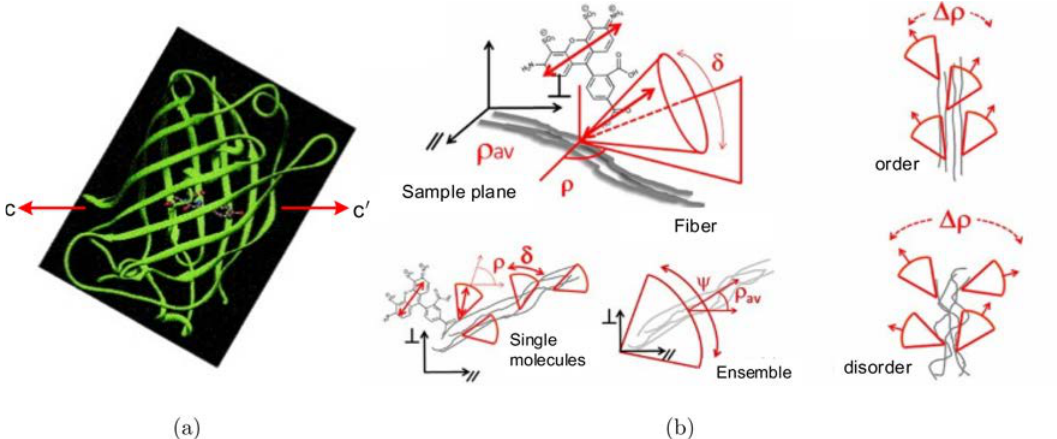
Fig. 1. Schematic illustration of °uorescent dipoles. (a) Schematic structure of Green Fluorescence Protein (GFP) molecule based on X-ray crystallographic analysis. The axis c – c 0 denotes the long crystal axis, which is also parallel to the orientation of the absorption and emission transition moments. (b) Fluorescent dipoles labeled on bio-structures (here, Alexa Fluor 488 labeled on actin, upper-left). Each molecule has its own average orientation ( (cid:2) ) and wobbling angle ( (cid:3) ). The ensemble dipole of the ¯laments behaves a di®erent property to the single dipoles with average orientation ( (cid:2) av ) and averaged cone aperture angle ( ) (lower-left). The statistic of neighboring dipoles, angular extent ( (cid:1) (cid:2) ), re°ects order or disorder of the system (right). (b) is adapted from Ref.